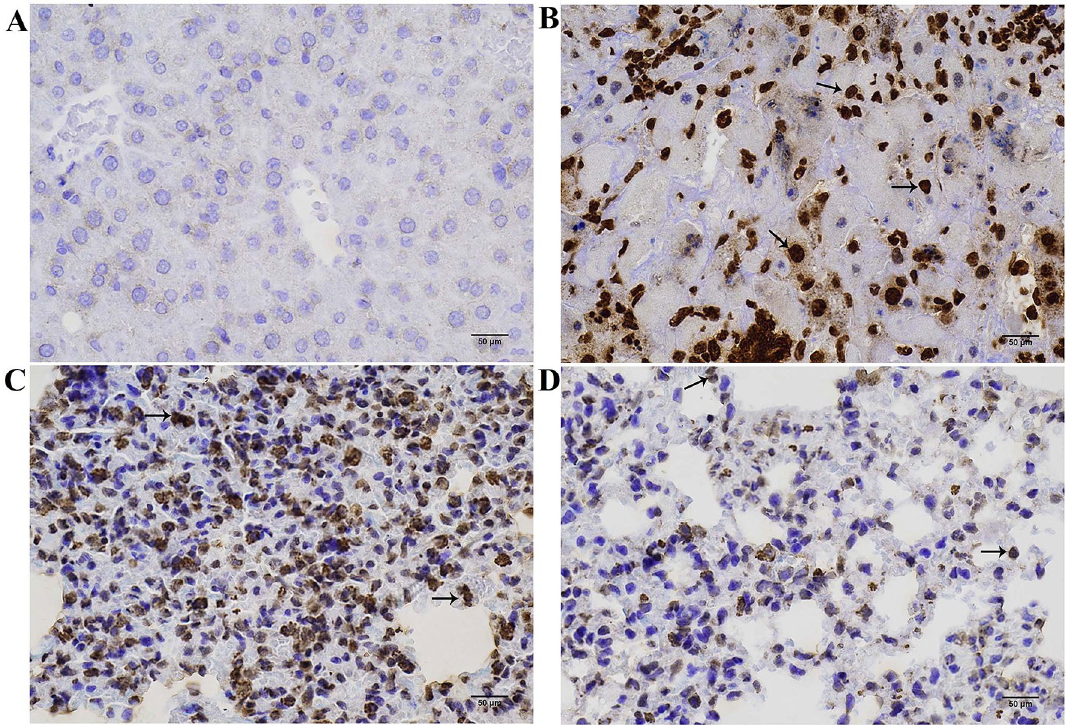
OSCC tissue; ( C ) The strongly positive expression of ANXA2 in low differentiated OSCC tissue; ( D ) The weakly positive expression of ANXA2 in high differentiated OSCC tissue. The black arrowheads marked ANXA2 stain positive cells. Scale bar: 25